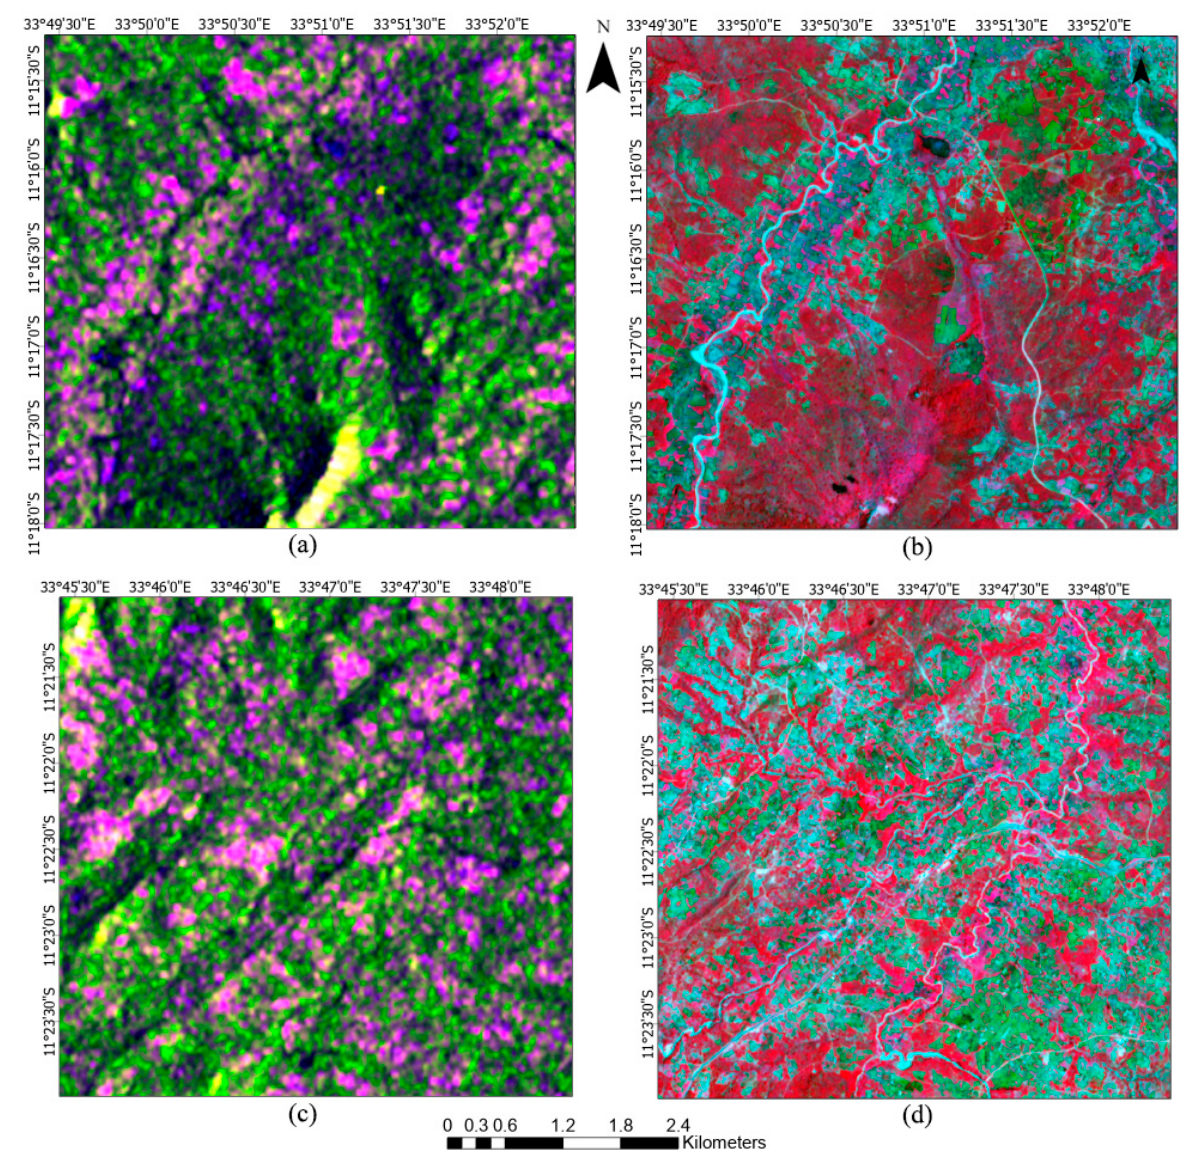
Figure 4. False color images of the Thimalala and Edundu, represented by ( a , c ) Sentinel-1 C 11 and C 22 backscatter response (RGB = C 11 , C 22 , C 11 /C 22 ) on 18/01/2020; ( b , d ) preprocessed Sentinel-2 image (RGB = NIR, red, green) on 07/01/2020.